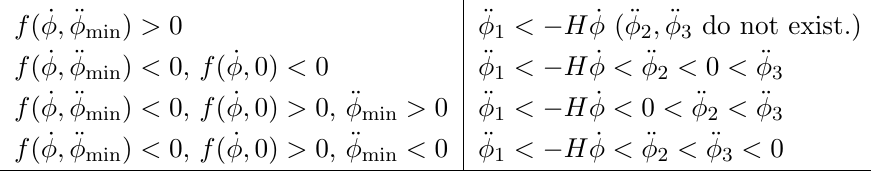
Table 1 . Solutions of f ( _ (cid:30); (cid:127) (cid:30) ) = 0 for given _ (cid:30) and their classi(cid:12)cation. Note that f ( _ (cid:30); (cid:127) (cid:30) min ( _ (cid:30) )) > 0 is equivalent to 0 < abe b < e (cid:0) 1